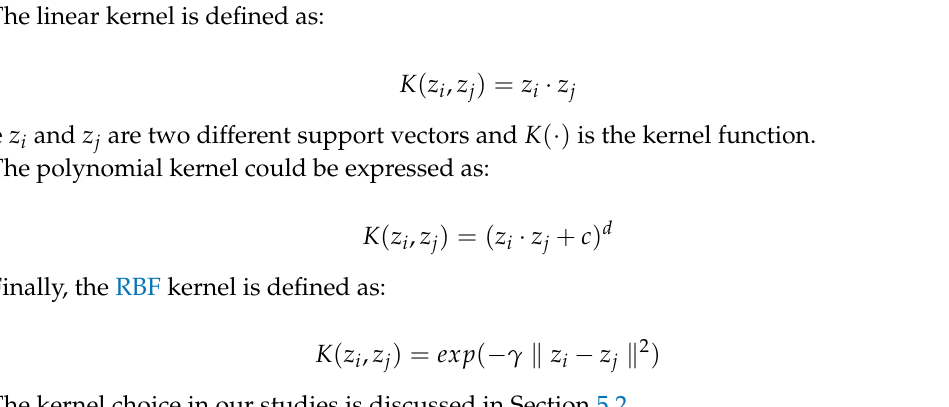
Figure 4. SVM binary classification with non-linear